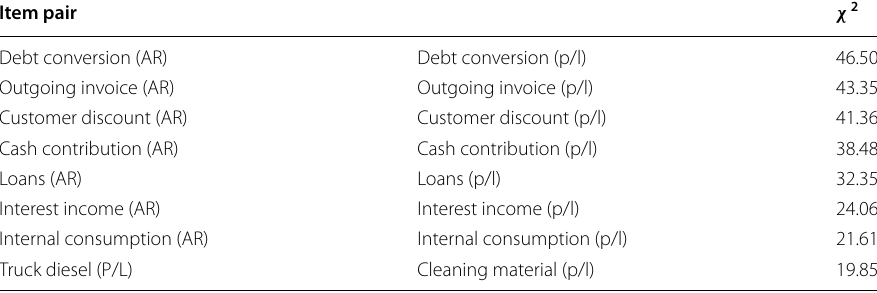
χ 2 Chi square values above threshold of 15. AR accounting record, P/L Profit/Loss effect estimation